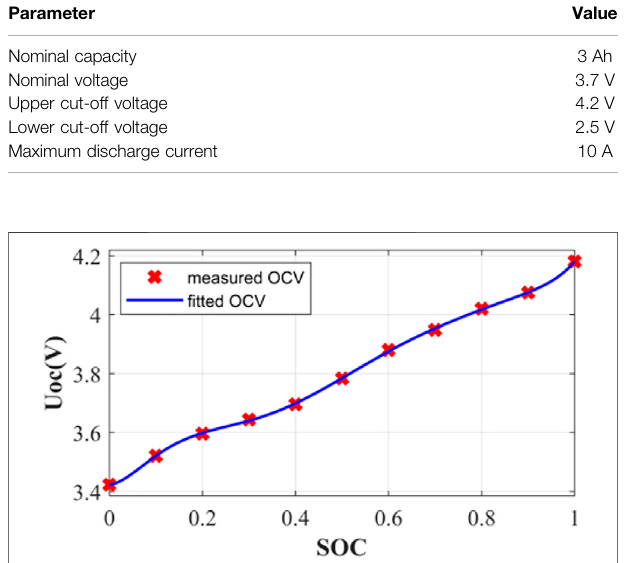
FIGURE 4 | Relationship curve of OCV versus